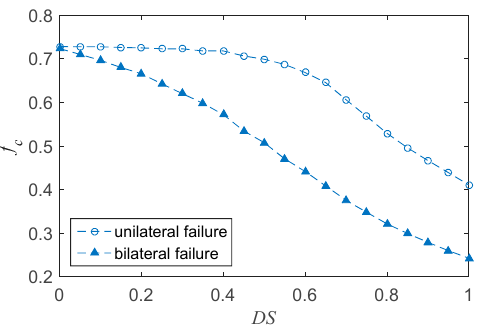
Figure 8. Collapse threshold f c as a function of dependency strength ( DS ), each point is obtained by averaging over simulation on 20 independent realizations.